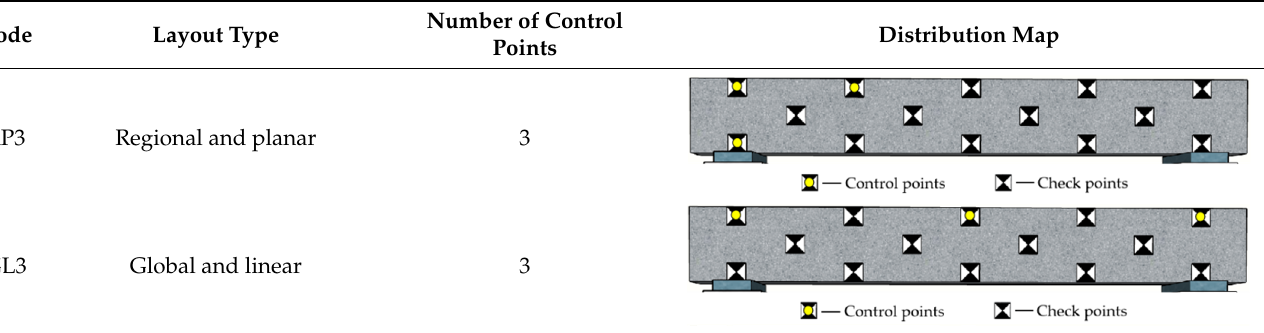
Table 2. Arrangement of reference points on the concrete beam.